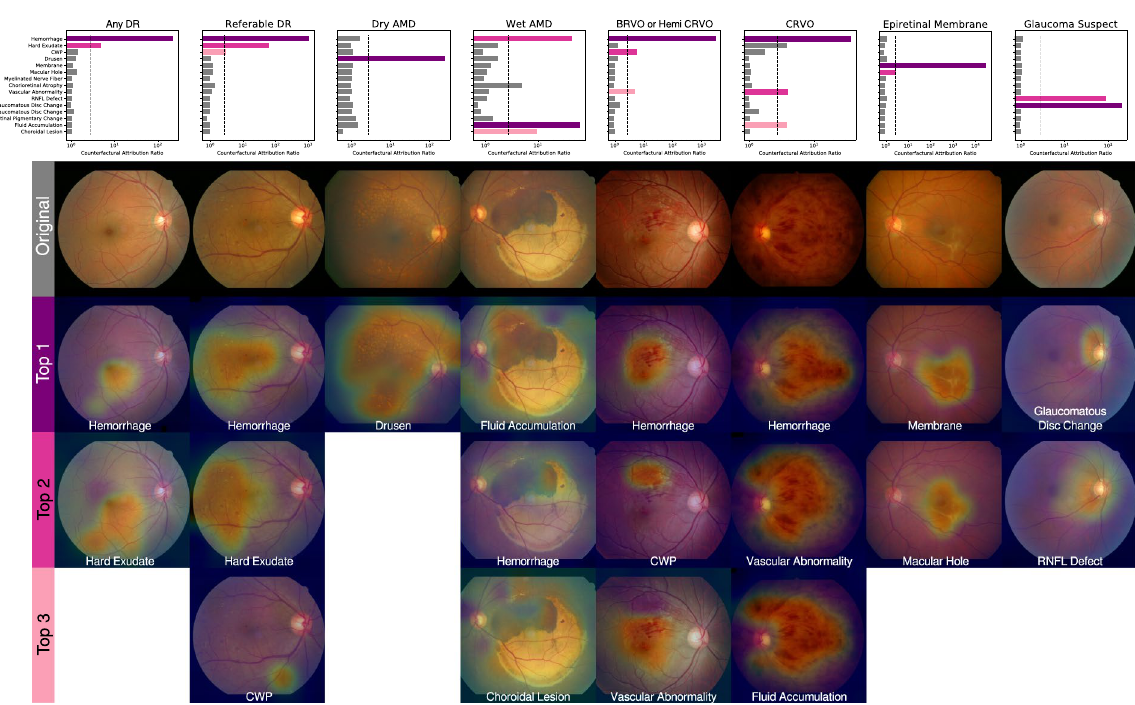
Figure 3. Use cases of counterfactual attribution ratio in diagnostic fundus examination. Lesions of top 3 findings above a threshold (natural constant e ) are shown (attribution activation